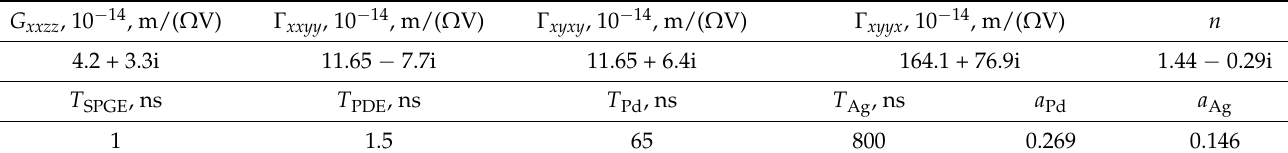
Table 1. The fitting parameters for the experimental data.